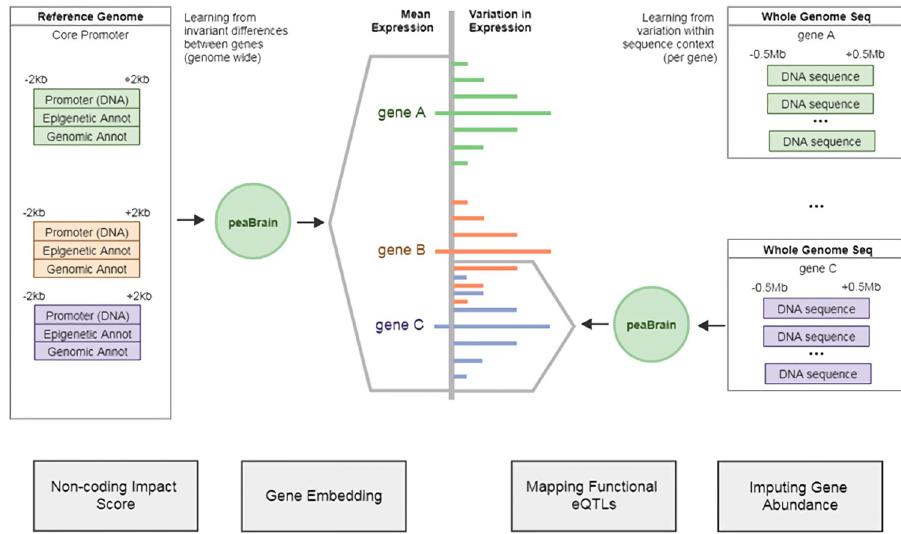
Fig 6. Schematic illustration comparing Stage 1 and Stage 2 peaBrain